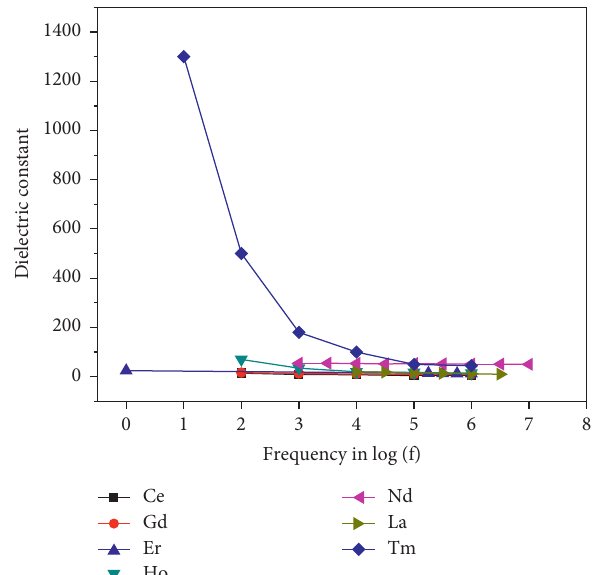
Figure 8: Variation of the dielectric constant of various rare earth metal-doped ZnO nanoparticles with respect to frequency.